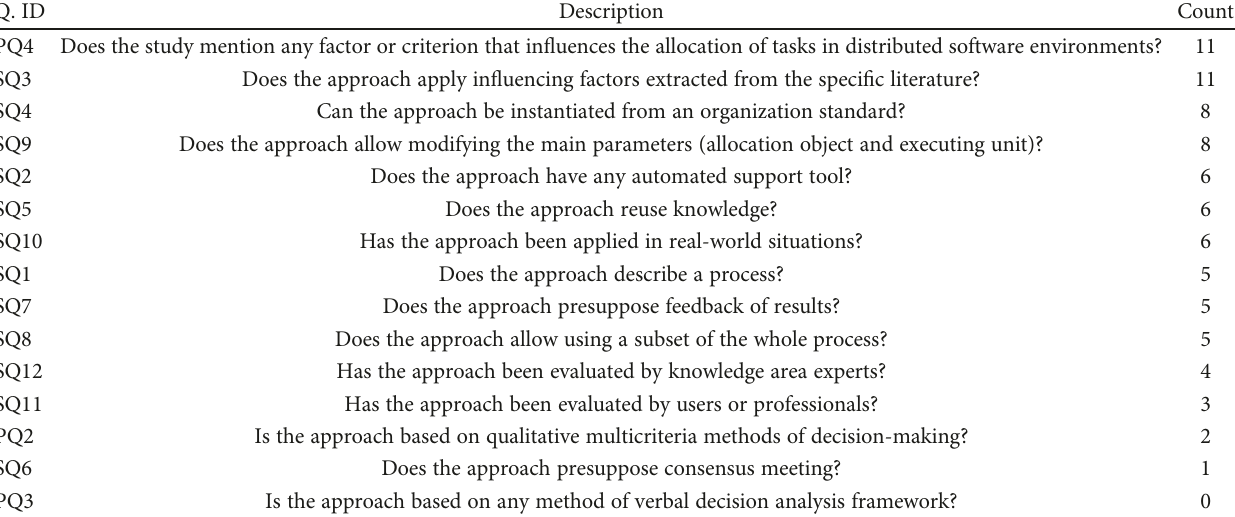
Table 7: Total approaches that scored for each question.